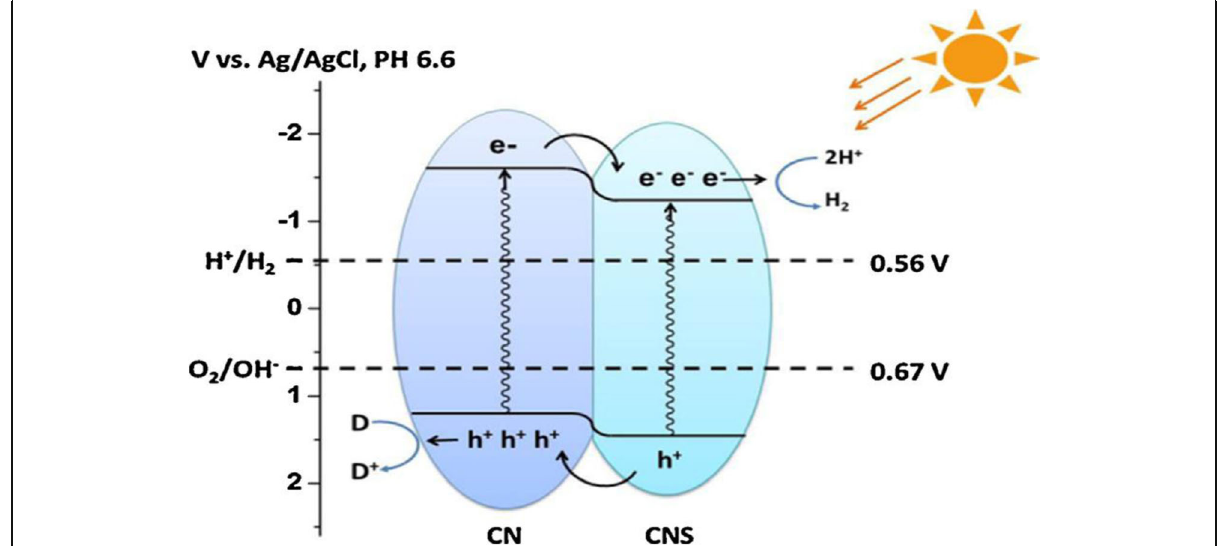
Fig. 2 Schematic illustration of organic heterojunction formed between g-C3N4 and S-doped g-C3N4. Reproduced from Ref. [115]. Copyright 2015.